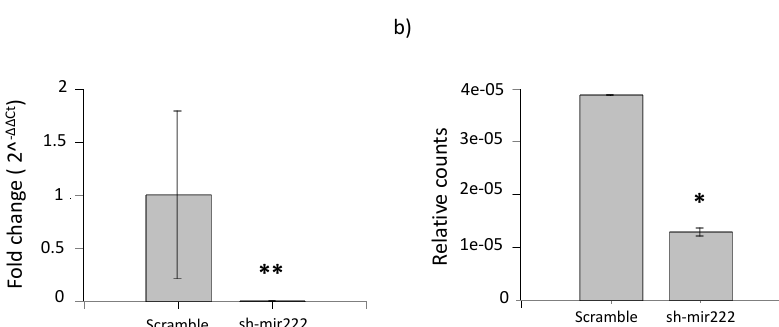
Figure A4. Efficiency of hsa-miRNA-222-5p knockdown in IgR39 cells. MicroRNAs silencing efficiency was evaluated by measuring hsa-miRNA-222-5p in IgR39 sponged cells (sh-mi222 5-p) according to the Materials and Methods section by relative expression and standard errors over three replica with qRT-PCR ( a ) (** p < 0.005) and microRNAs abundance ( b ). Significance has been assessed using EdgeR (* p -value < 0.05). Cells sponged with a scramble miRNA sequence (Scramble, see the Materials and Methods section) was used as a control.